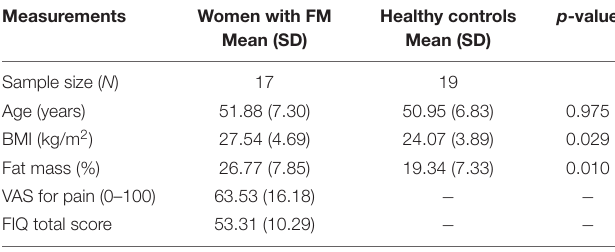
TABLE 1 | Participants’